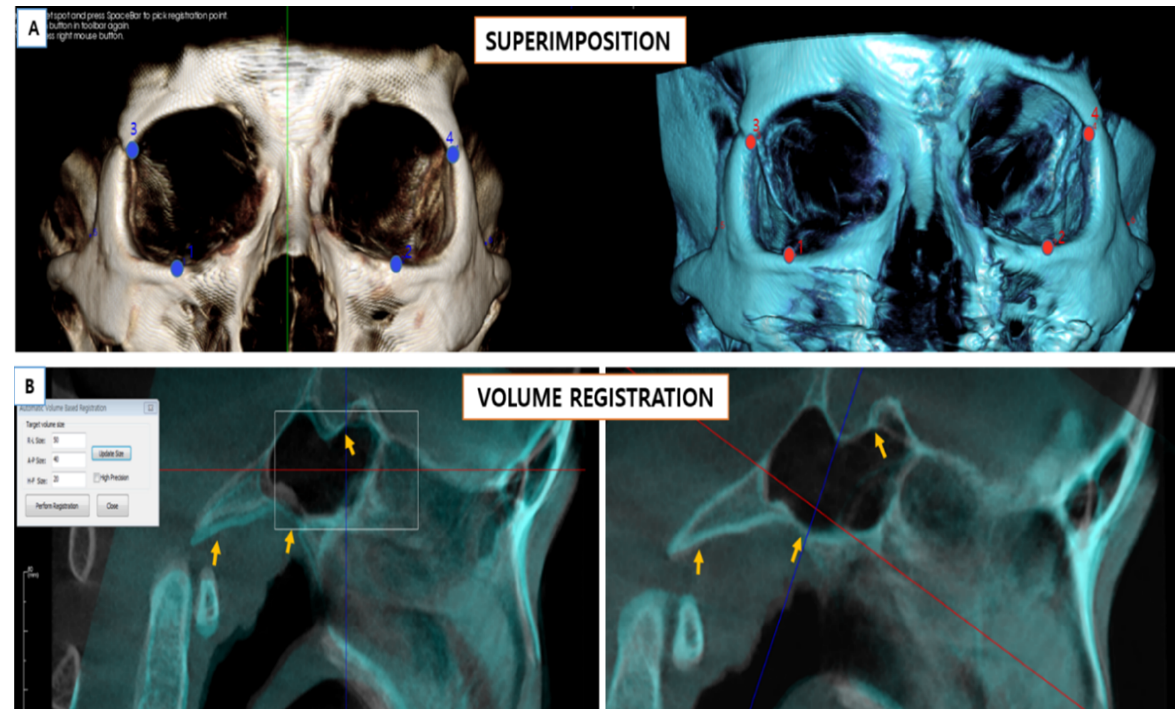
Figure 2. Reorientation of the CBCT according to the Frankfort horizontal plane.